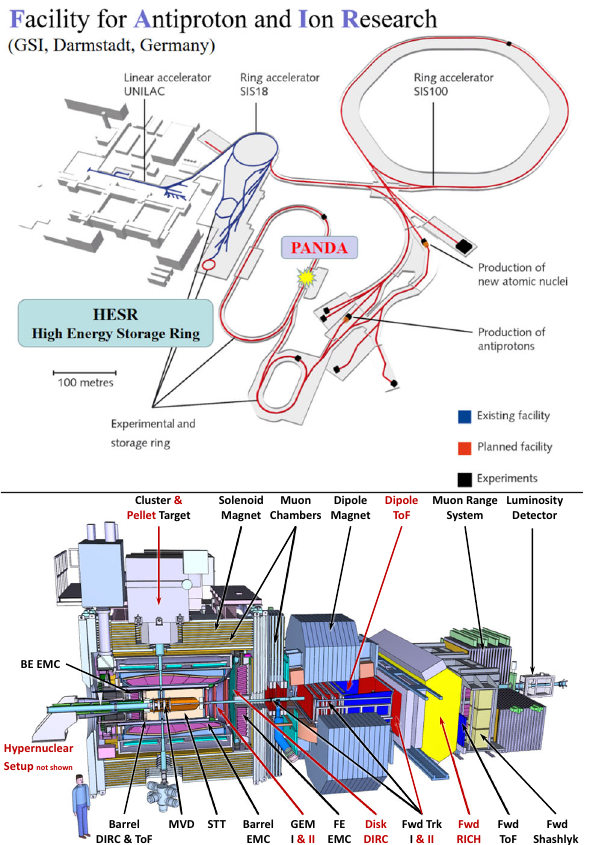
Fig. 1 Overview of the FAIR facility (top). The PANDA experimental setup (bottom) with the initial detectors (in black) and staged upgrades (in red) [3] (and references therein)